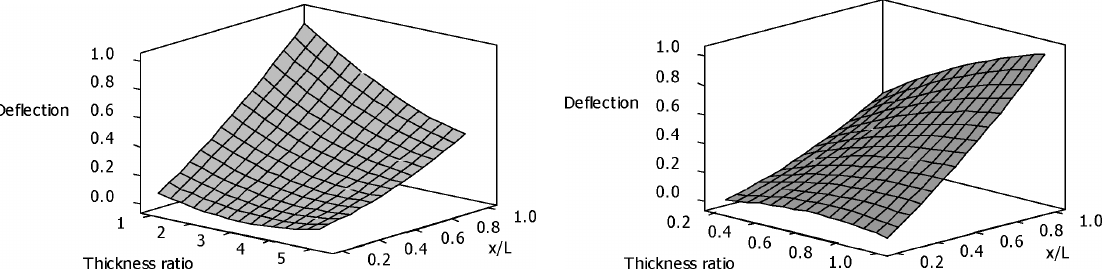
Fig. 9. Surface plot of static de fl ection of the welded beam with axial position and thickness ratio greater than one.